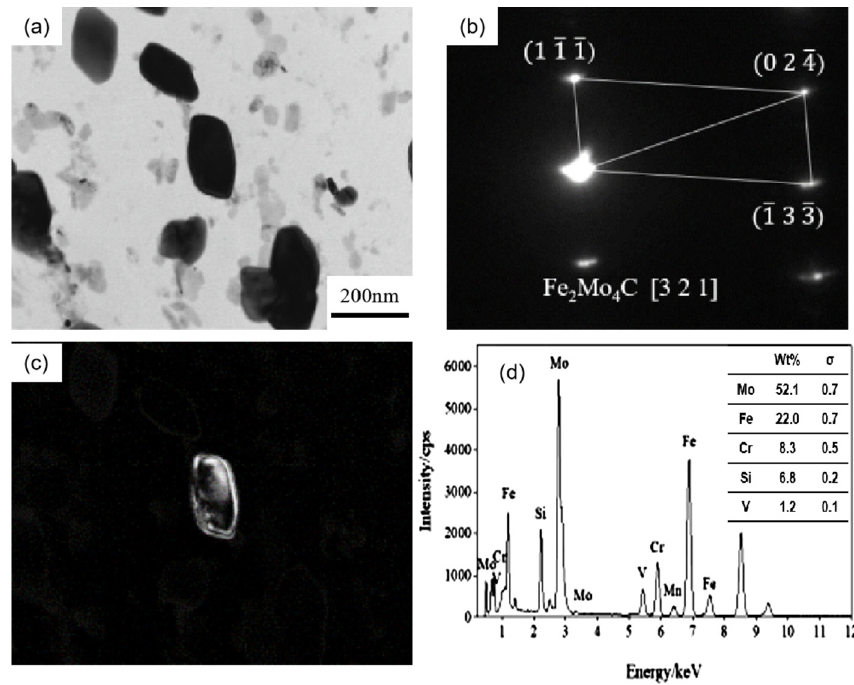
Figure 7. TEM of M6C carbide in 1.0 Si steel after tempering for 64 h at 650 °C: ( a ) bright field image of carbide; ( b ) SAEDpattern; ( c ) corresponding dark field image; ( d ) EDS analysis.